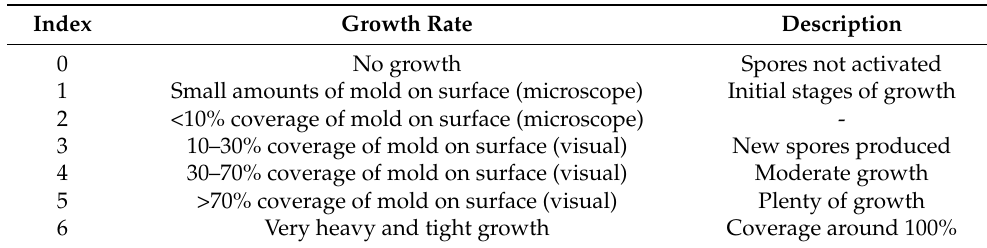
Table 2. Description of the mold growth index [41].